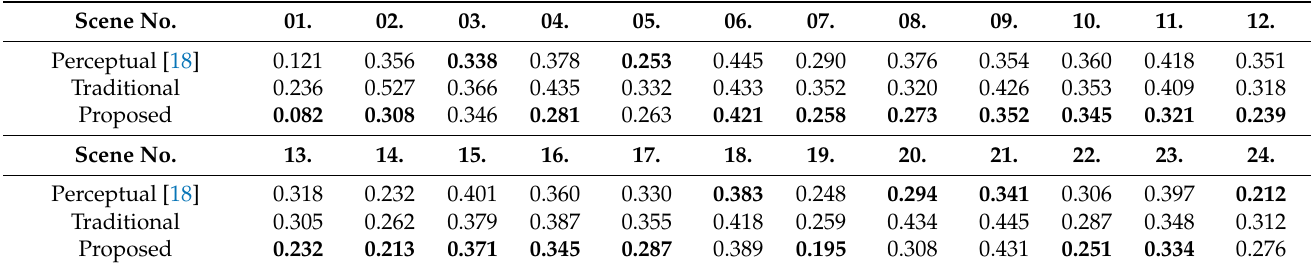
Table 1. Objective quality scores Q of seams obtained with different methods. Scene